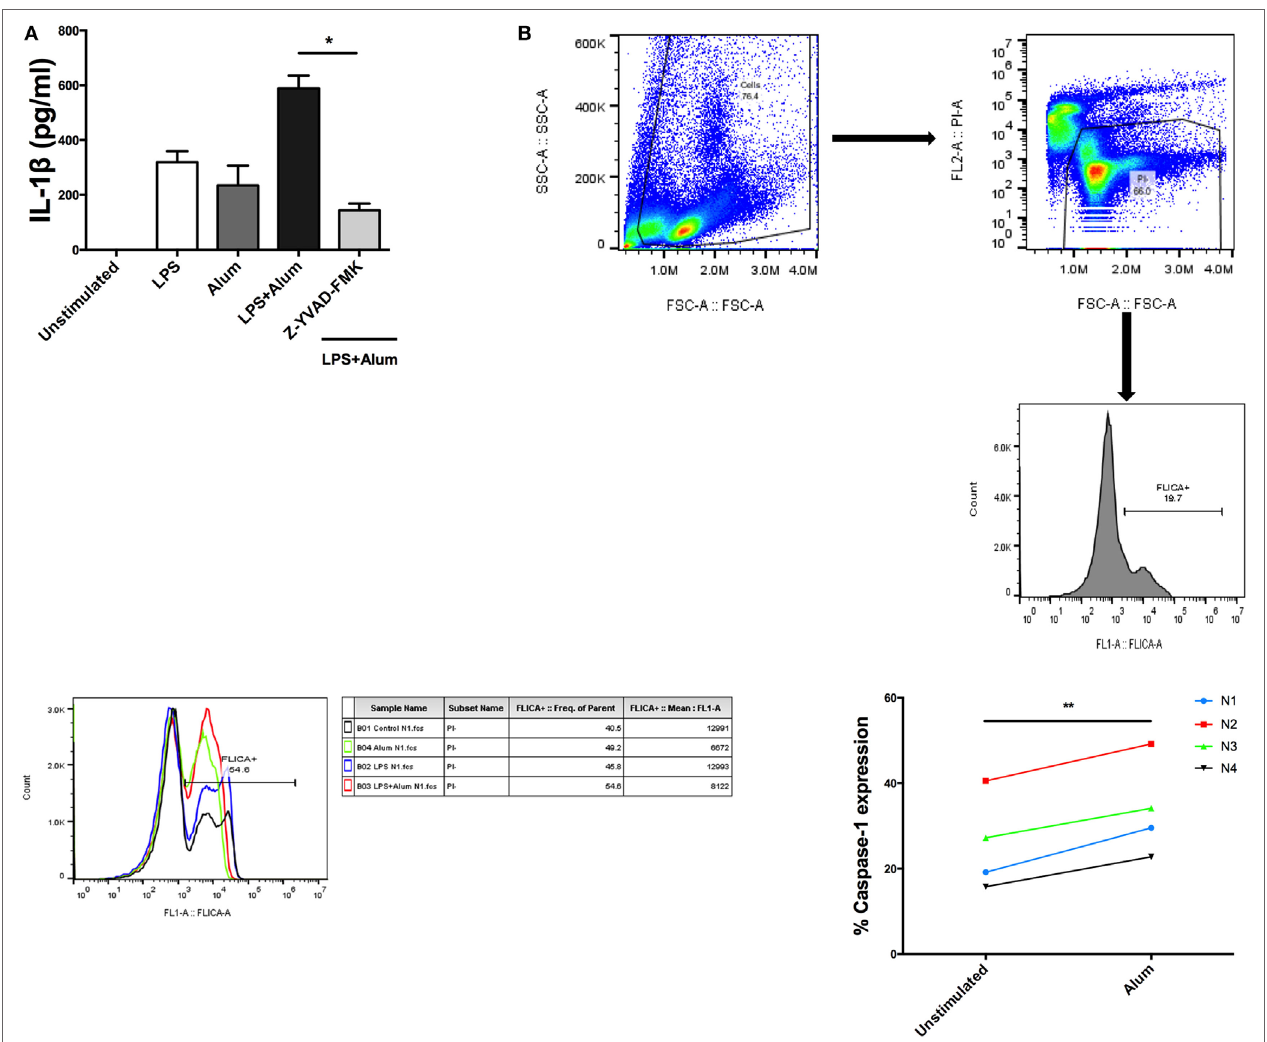
FigUre 4 | Alum-induced IL-1 β secretion is caspase-1 dependent. LPS (100 pg/ml)-primed cells from three animals were incubated with Z-YVAD-FMK (10 µM) for 40 min. Following this, the cells were stimulated with alum (50 µg/ml) for 24 h and supernatants were then harvested and analyzed by ELISA for IL-1 β (a) . Cells were seeded (1.5 × 10 6 ) and treated with LPS and alum for 2 h. Following this, the cells were analyzed by flow cytometry to assay for caspase-1 (B) . The data are representative of four animals ( < 1 year old) (B) . For ELISA analysis, results are mean cytokine concentrations ( + SEM) in supernatants that were tested individually in triplicate. * p < 0.05, ** p < 0.01, *** p < 0.001 were calculated using